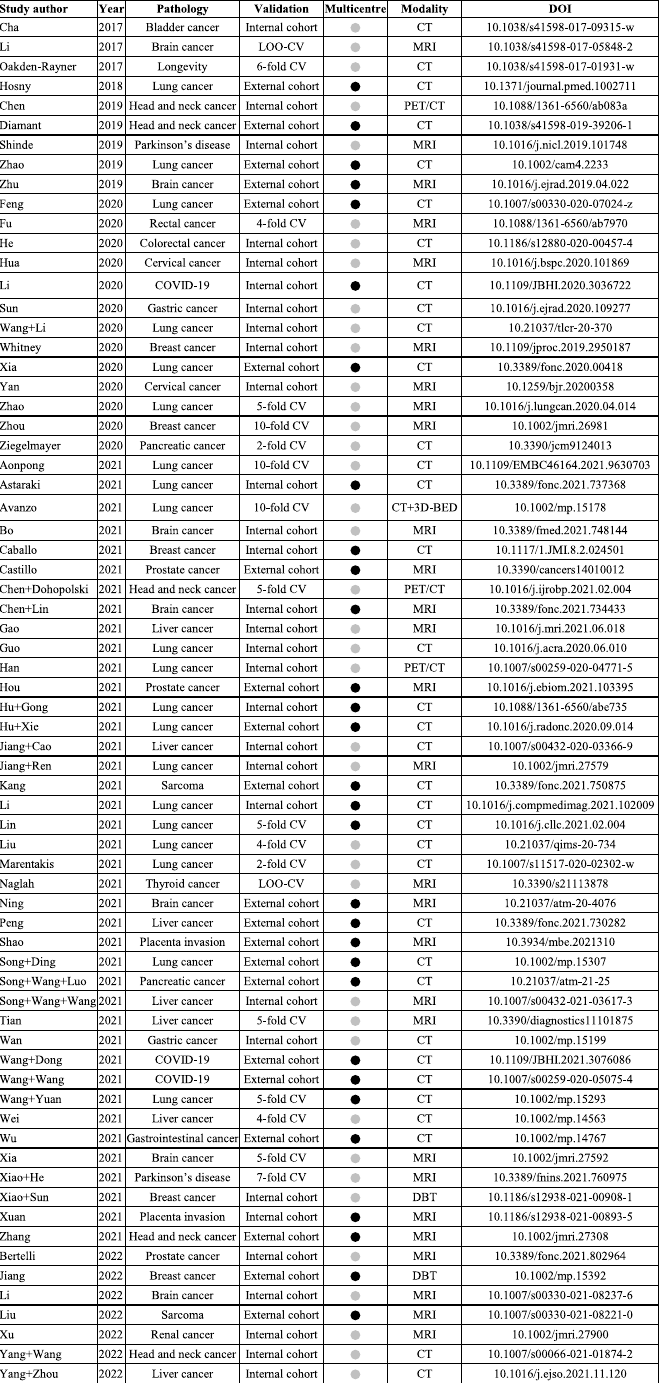
Table 1 Overview of the characteristics of all included